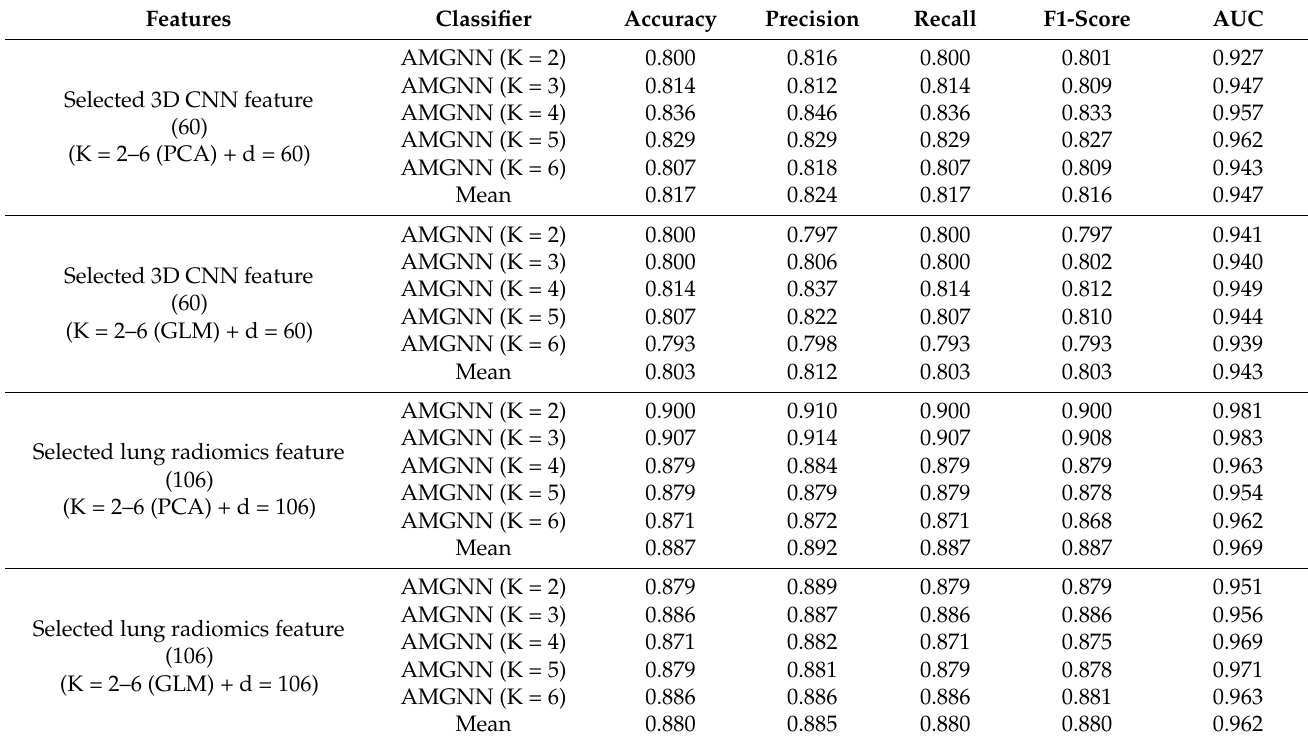
Table 9. The AMGNN classifier’s performance on the test set in Experiment 3.